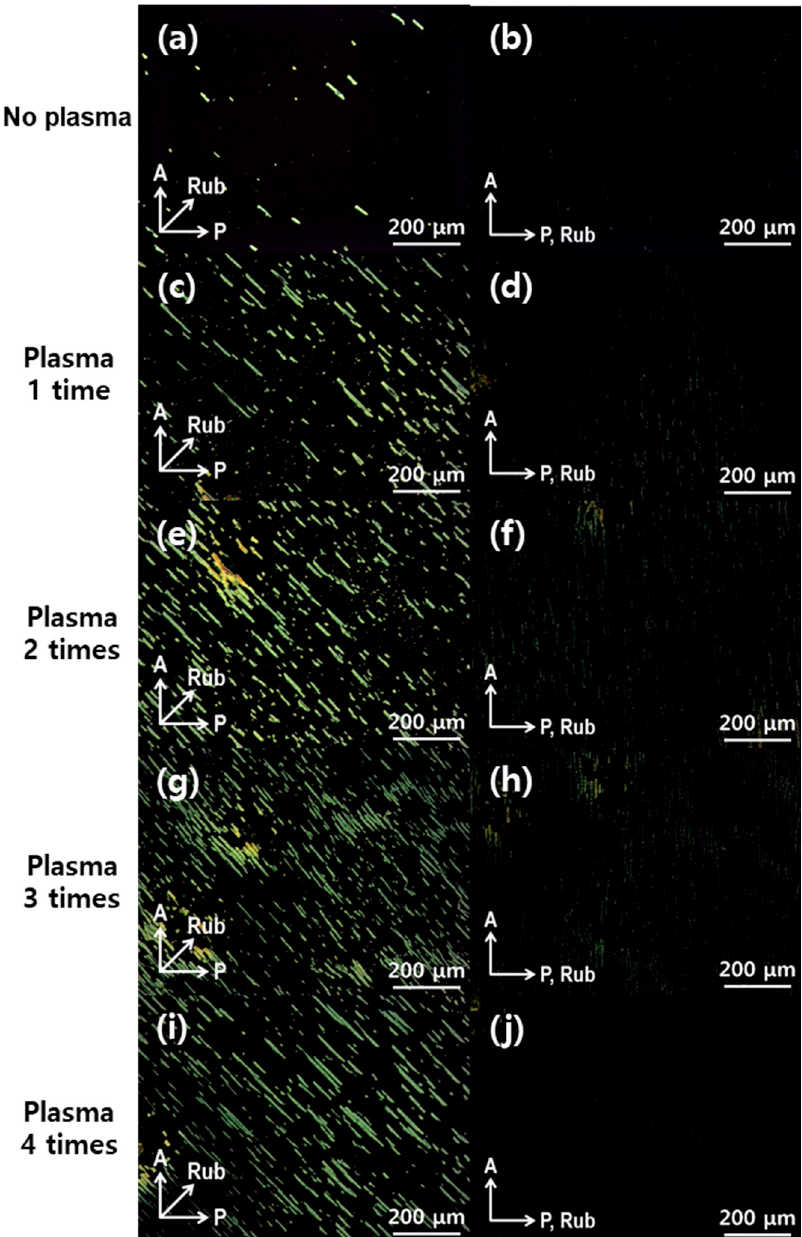
Figure 7. POM images of the HCM026 samples located between the crossed polarizers. The number of plasma treatment times was varied before rubbing. ( a , b ) No plasma treatment and plasma treated ( c , d ) 1, ( e , f ) 2, ( g , h ) 3, and ( i , j ) 4 times.